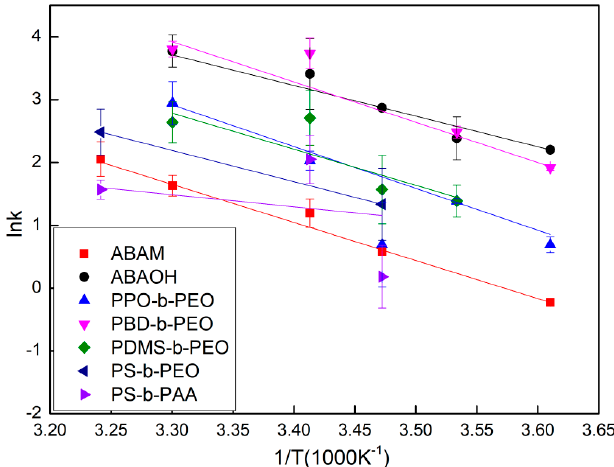
Figure 3. Arrhenius plots for the calculation of the activation energy for osmotic transportation of water across blank polymer vesicles.